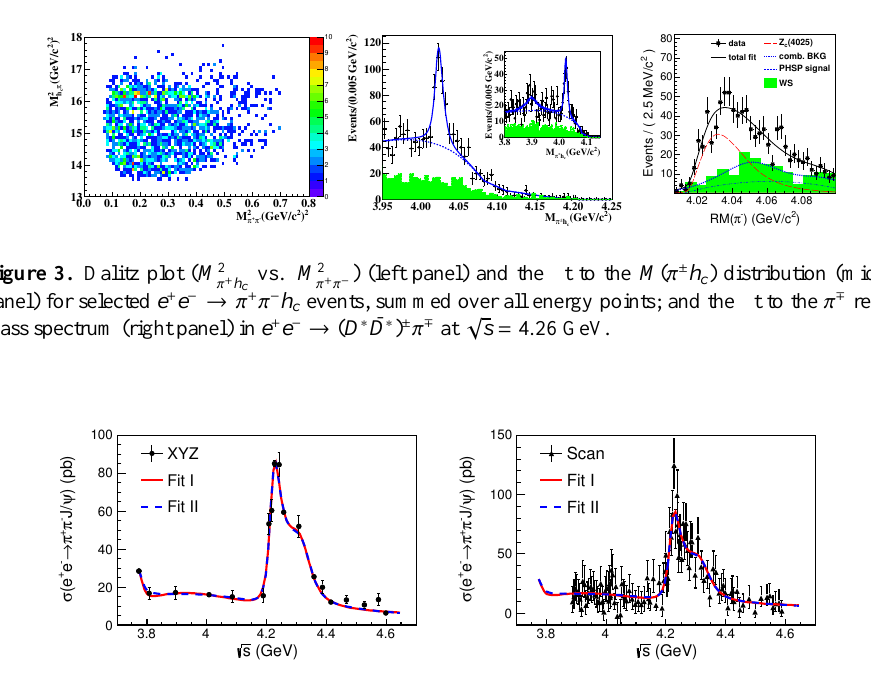
Figure 4. Measured cross section σ ( e + e − → π + π − J /ψ ) and the fit to the data.